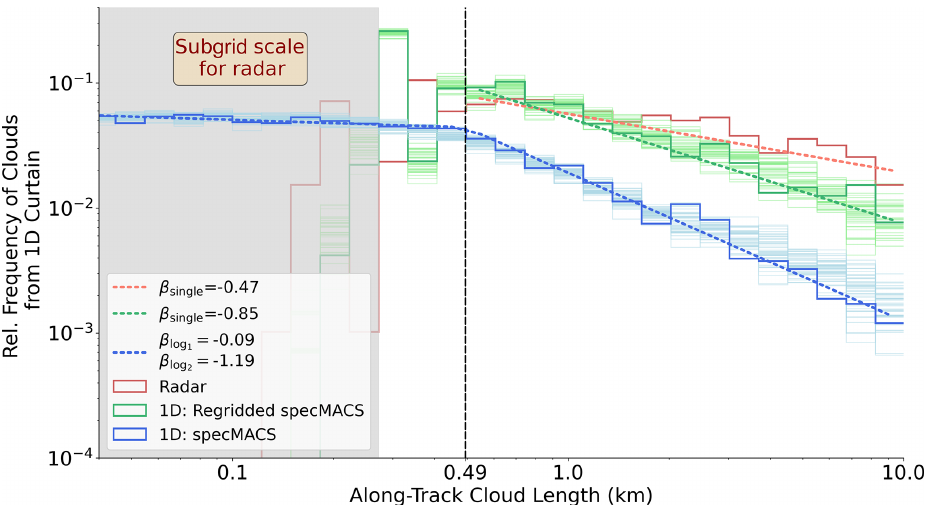
Figure 6. Along-track cloud size distribution from radar and imager (specMACS) within the 1D transect of their unanimous FOV (bold). For the imager, the high resolution and regridded cloud mask (imitating radar 1Hz resolution) are considered. Power law fits are shown as dashed lines. The vertical dashed line represents the scale break resulting from the double power law fit for the imager (blue distribution). Thin distributions illustrate cloud along-track chord lengths from successive curtains parallel to radar transect (discussed in Sect.